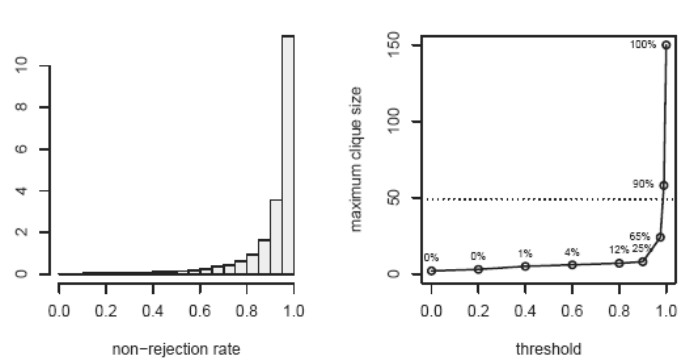
Figure 10 – Estrogen receptor data of West et al. (2001): qp -hist and qp -clique plots for q